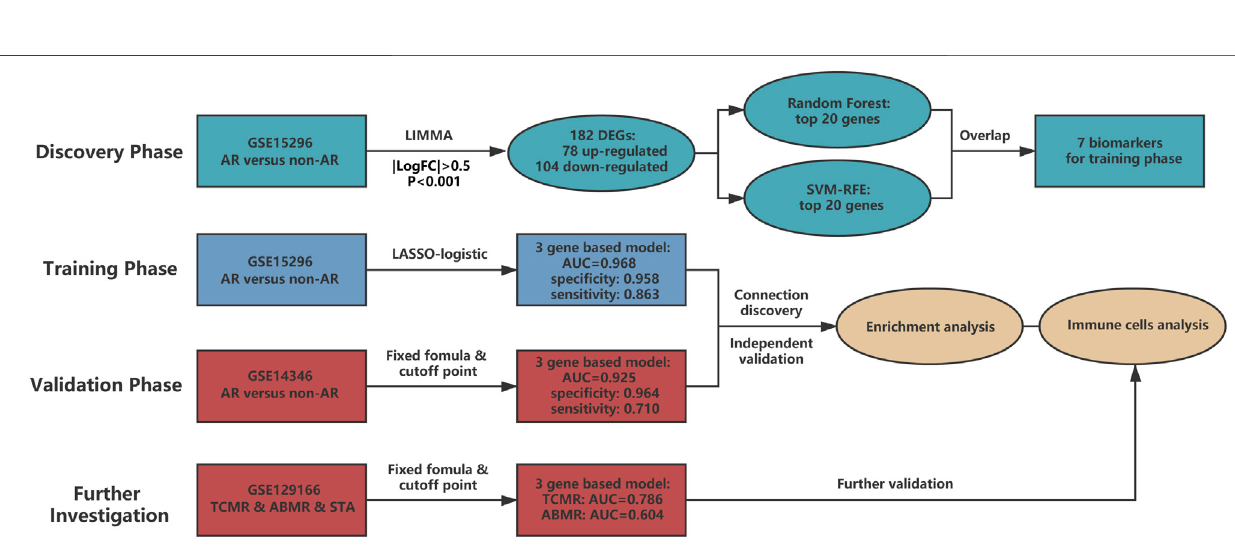
FIGURE 2 | The main structure of current study. Four phases are included in our research. The discovery phase chose candidate biomarkers for AR, and then biomarkers were utilized to develop a three-gene based model in the training phase. Diagnostic ability of the model was deeply veri fi ed in the validation and further investigation phases. Gene set enrichment analysis and immune cell analysis were also conducted to detect potential mechanisms of AR. AUC: area under the curve. TCMR: T cell-mediated rejection. ABMR: antibody-mediated rejection. STA: stable. SVM-RFE: support vector machine - recursive feature